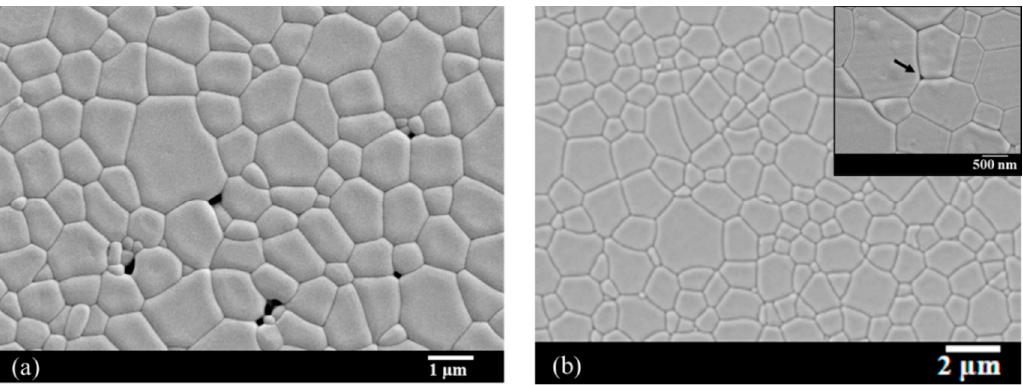
Figure 10. SEM micrographs of 1% Nd:YAG ceramics (a) pre-sintered under vacuum at 1625 °C for 5 h; and ( a ) after post-Hot Isostatic Pressing (HIP) at 1625 °C for 30 min under 190 MPa of argon gas. Insert at higher magnification in ( b ) shows a residual pore with about a 50 nm diameter (arrow) after post-HIP.